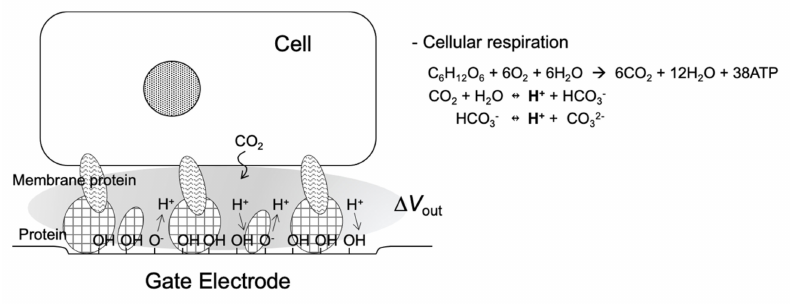
Figure 2. Schematic illustration of nanogap interface between cell and